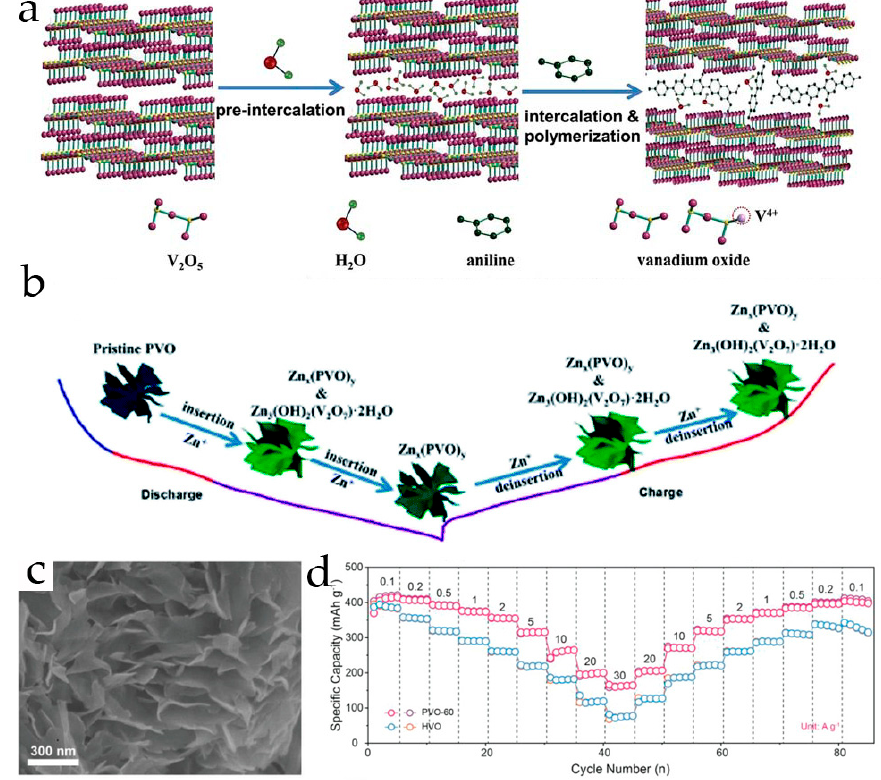
Figure 2. ( a ) Scheme of the PVO preparation processes [53]; ( b ) Scheme of the reversible zinc storage mechanism in the PVO electrode [53]; ( c ) SEM image of as-prepared PVO-60 sample [60]; ( d ) Rate capability of PVO-60 and HVO at various current densities [60].